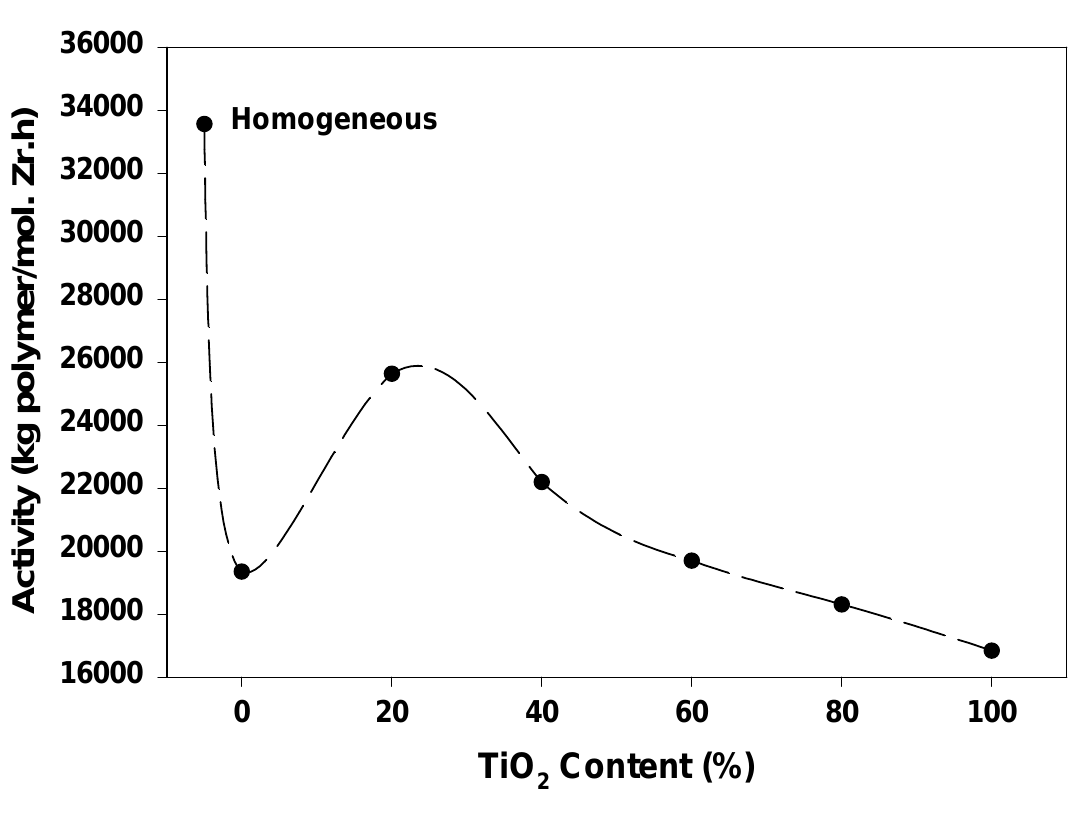
Figure 3. Activities of EH copolymerization via various mixed oxides-supported MAO and homogeneous